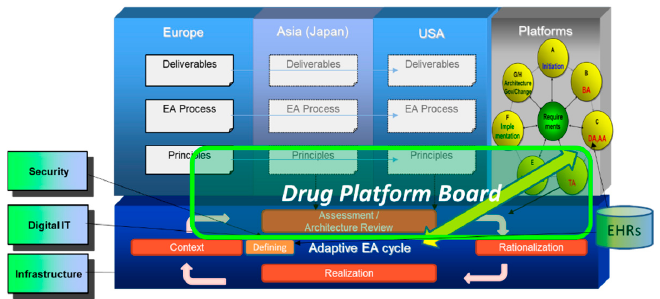
Figure 11. AIDAF proposed framework with drug platform board.